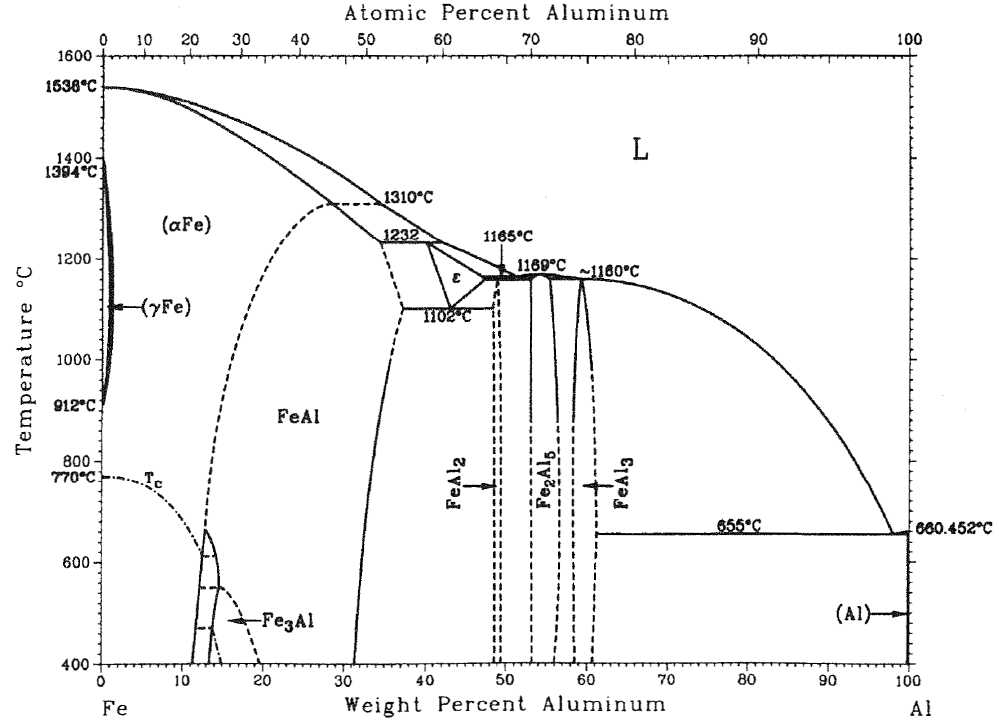
Figure 2. Fe ‐ Al phase diagram [7]. Figure 2. Fe-Al phase diagram